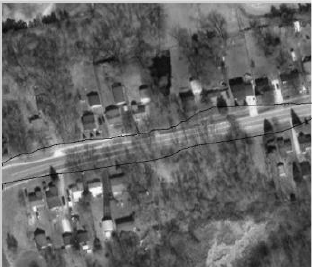
Figure 15: Ziplock Snake with Gaussian Kernel (30x30)